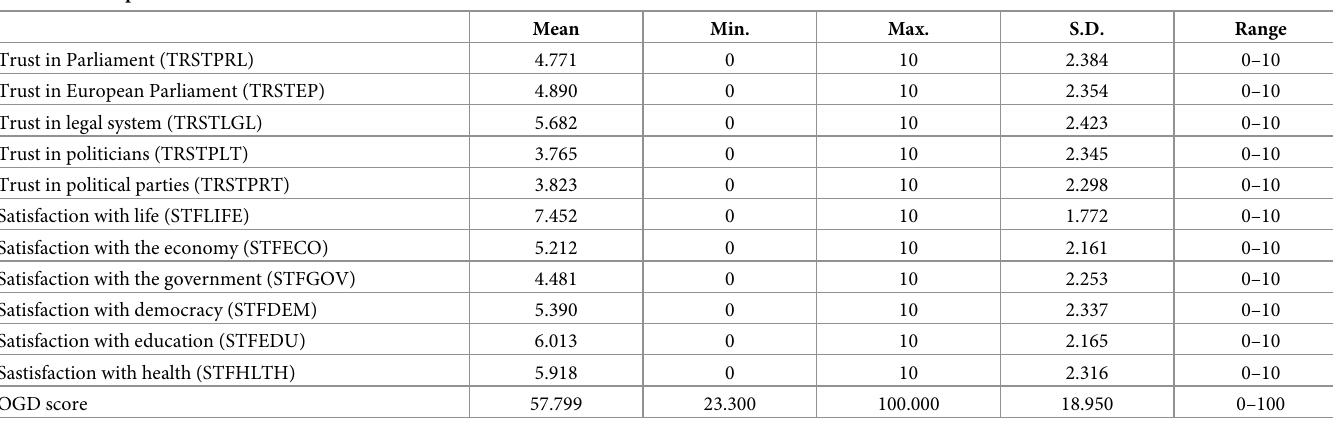
Table 1. Descriptive statistics of the model